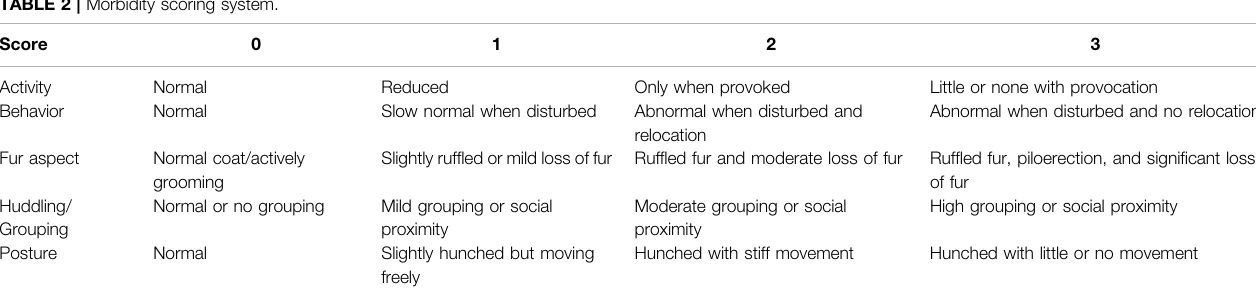
TABLE 2 | Morbidity scoring